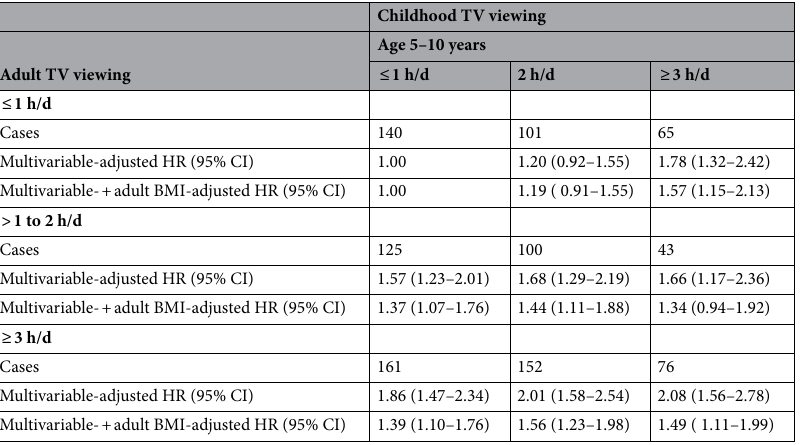
Table 5. Joint associations of TV viewing at ages 5–10 years and during adulthood with diabetes in adult life among participants of the Nurses’ Health II cohort between 2001 and 2013. TV television, HR hazard ratio, CI confidence interval. Multivariable model adjusted for age of nurse (continuous) and follow-up cycle, race (White, Non-White), family history of diabetes (yes, no), maternal education (1–3 yrs of high school or less’, 4 yrs of high school, 1–3 yrs of college, 4 + yrs of college), maternal pre-pregnancy body mass index (quintiles), paternal body mass index at nurses’ birth (quintiles), maternal weight gain during pregnancy (<